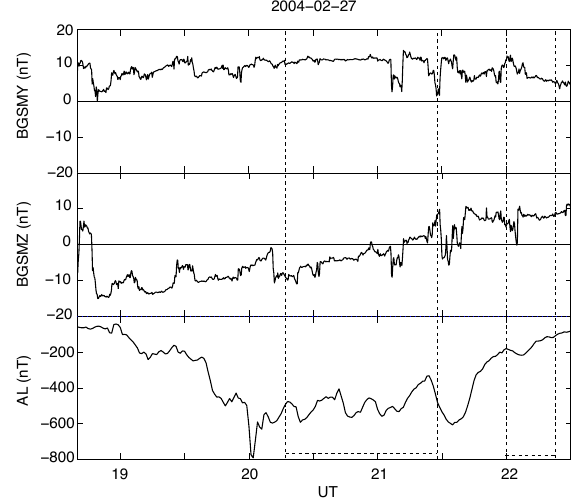
Fig. 2. Two top panels show IMF B y and B z in the GSM coor- dinates as measured by the ACE satellite. The time is delayed by 55min to account for propagation to the subsolar magnetopause. Bottom panel shows the AL index. The two time intervals marked by vertical lines relate to the PCB fluctuations as observed by EIS- CAT, and the Cluster pass in the PSBL in the end of the recovery phase,